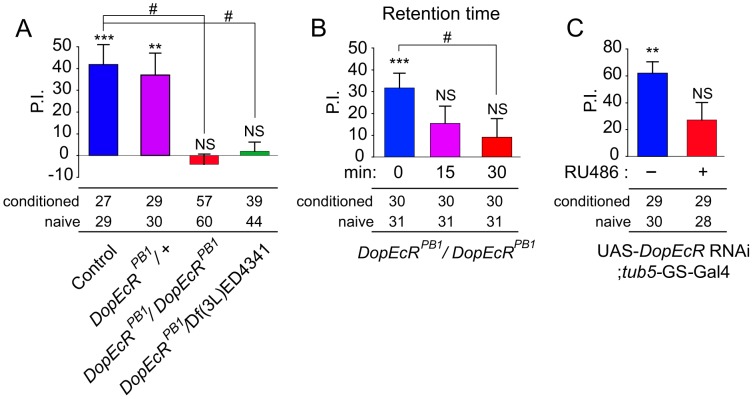
DopEcR is required for the 30-minute courtship memory induced by 1-hour courtship conditioning.(A) Thirty-minute courtship memory in wild-type flies (control) and flies heterozygous (DopEcRPB1/+), homozygous (DopEcRPB1/DopEcRPB1), and hemizygous (DopEcRPB1/Df(3L)ED4341) for DopEcR. DopEcRPB1 homozygotes and hemizygotes were defective for 30-minute courtship memory. (B) Time course of courtship memory in DopEcRPB1 homozygotes. Significant memory was observed immediately after conditioning, but not 15 or 30 minutes after conditioning. (C) A defect in 30-minute courtship memory in flies that ubiquitously express the DopEcR RNAi after eclosion, in response to RU486 stimulation of the tub-GS-Gal4 driver. The presence or absence of courtship memory was evaluated by applying the Mann–Whitney U-test to naïve and conditioned males. Statistical significance is shown above each bar as NS, no significant difference, **, P<0.01 or ***, P<0.001. Sample numbers for naïve and conditioned flies are shown under each graph. PIs were analyzed using Krustal-Wallis One-Way ANOVA, followed by Dunn's pairwise test for multiple comparisons. #, P<0.05; ##, P<0.01. Error bars (s.e.m.).